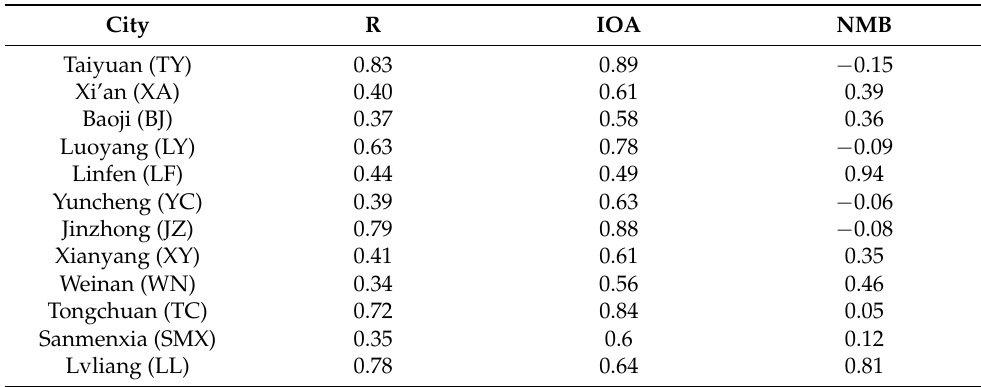
Figure 4. The observed and predicted concentrations of ozone. Table 5. Assessment parameters for ozone